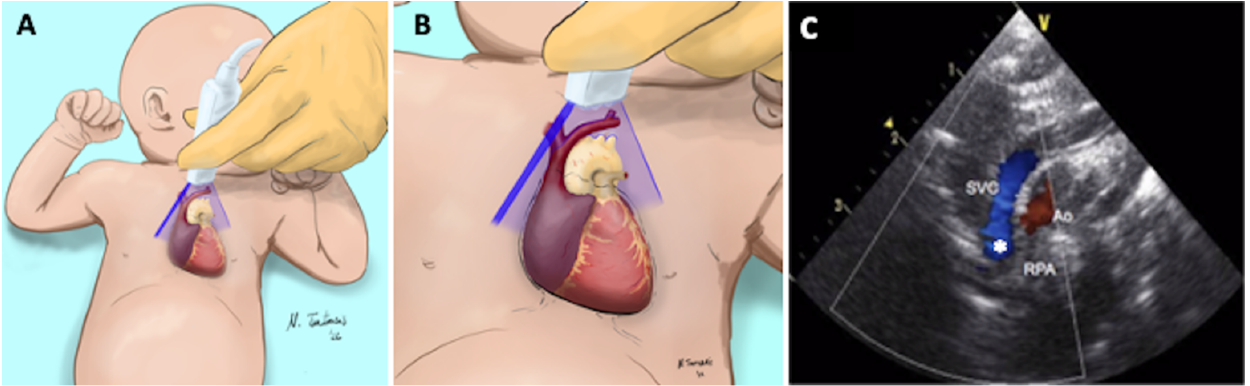
Figure 5. Suprasternal view of the SVC. ( A ) The sector probe is placed near the suprasternal notch. The orientation marker is pointed towards 1:00 to 2:00. ( B ) The ultrasound beam is parallel to the SVC, ( C ) The following structures are visualized: superior vena cava (SVC), aorta (Ao), right pulmonary artery (RPA). The sample volume of the pulsed wave doppler (*) is placed in the SVC at the level of the RPA.